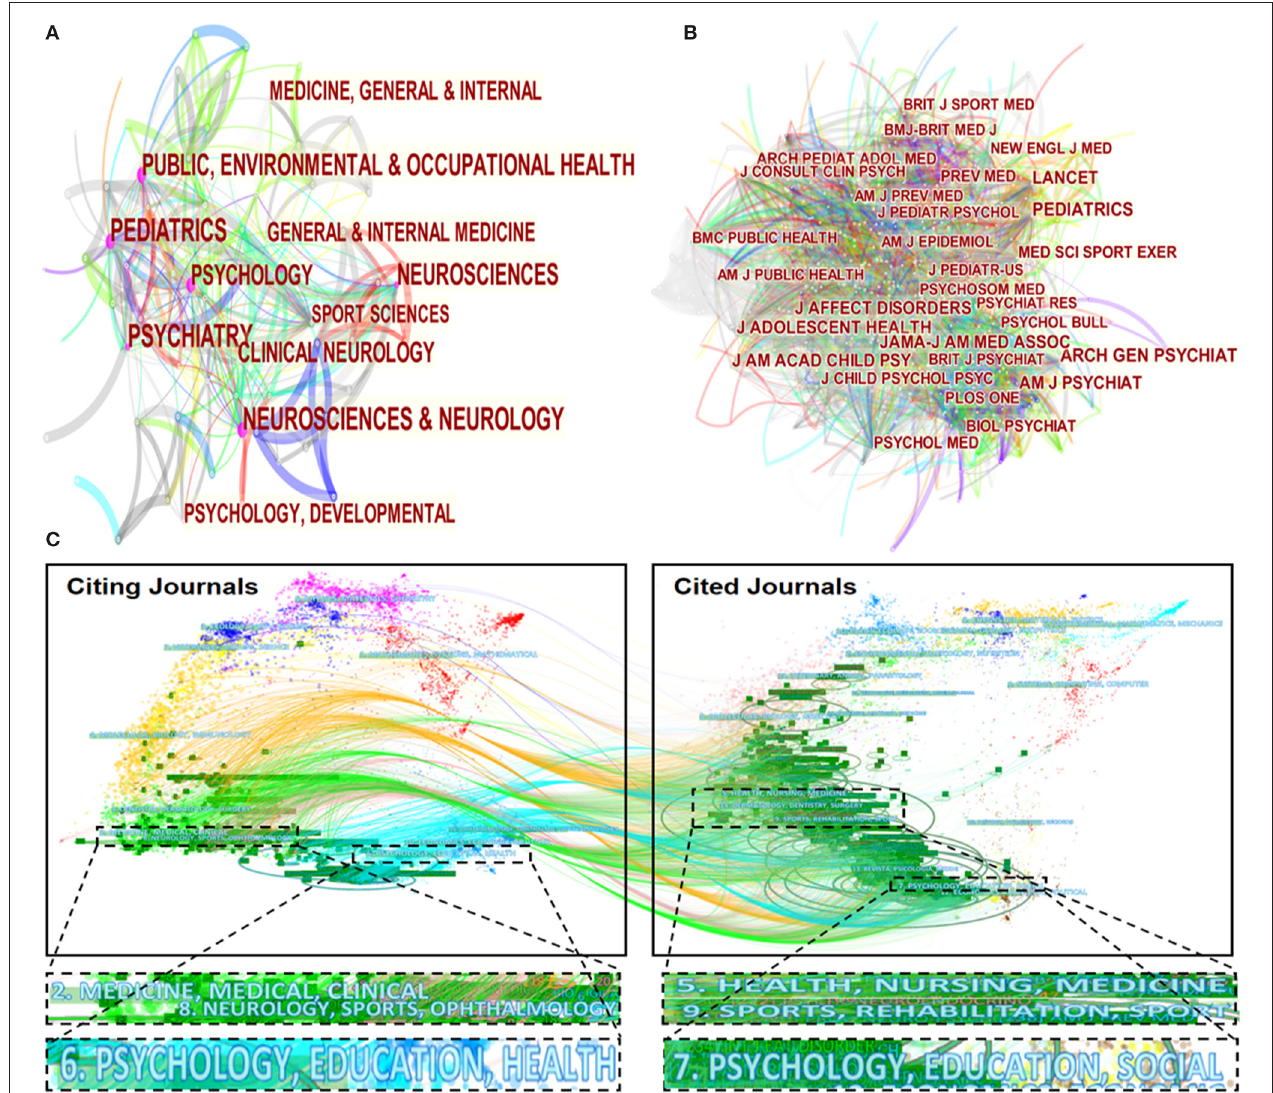
FIGURE 3 | The distribution of categories and journals. (A) Map of categories with publications in exercise-depression-teenager research. (B) Map of journals with publications in exercise-depression-teenager research. (C) Dual-map overlay of journals that published work related to exercise-depression-teenager